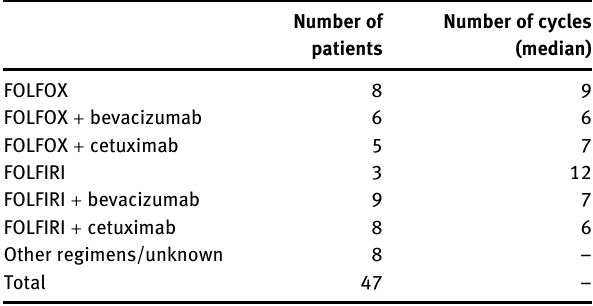
Table  : Regimen used for the last line of prior chemotherapy. Number of